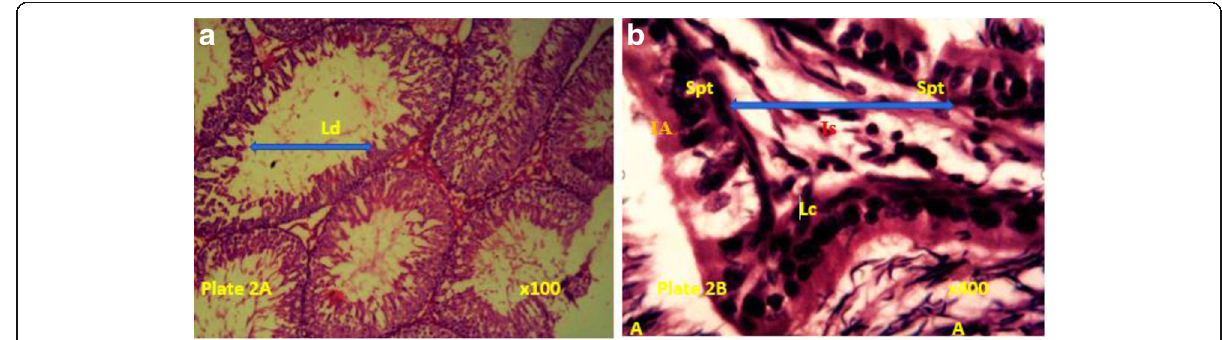
Fig. 6 a , b Photomicrograph of testes of the negative control group: Representative testicular micrograph of Wistar rats given 100mg of aluminum chloride per kg of body weight, showing the abnormal structure of seminiferous tubules. Distortion of most cells and degenerative changes of seminiferous tubules (IA); Widening interstitial space and diffuse edematous changes with mononuclear cell infiltrations besides basement membranes separating from the underlying layers ( a ). Ld Luminal diameter, Spt spermatogonia, It Interstitial space, Lc Leydig cell, Spz spermatozoa. The stain is H&E and Magnification x 100, x